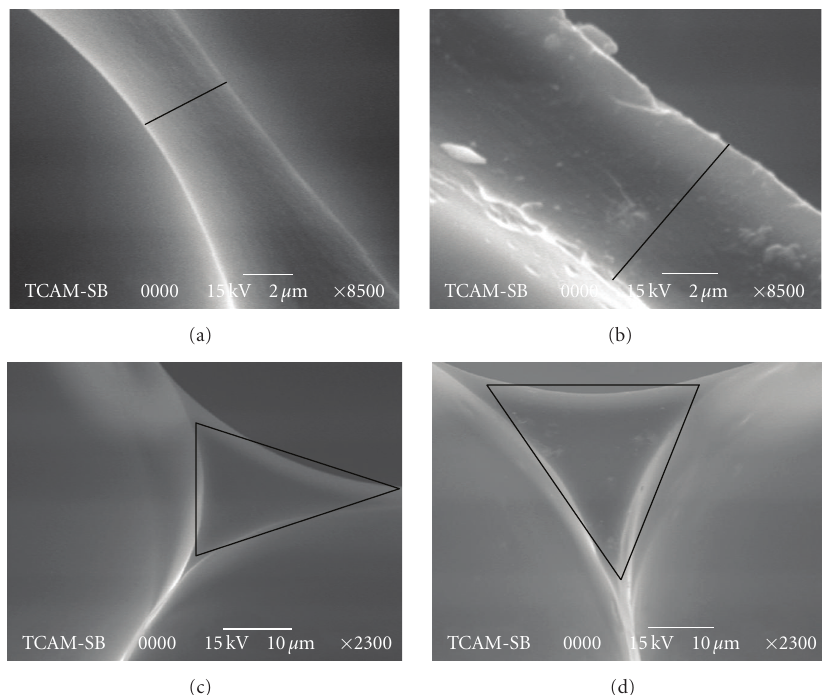
Figure 4: Cell walls of (a) neat and (b) nanophased polyurethane foam and cross-section of cell edges of (c) neat and (d) nanophased polyurethane